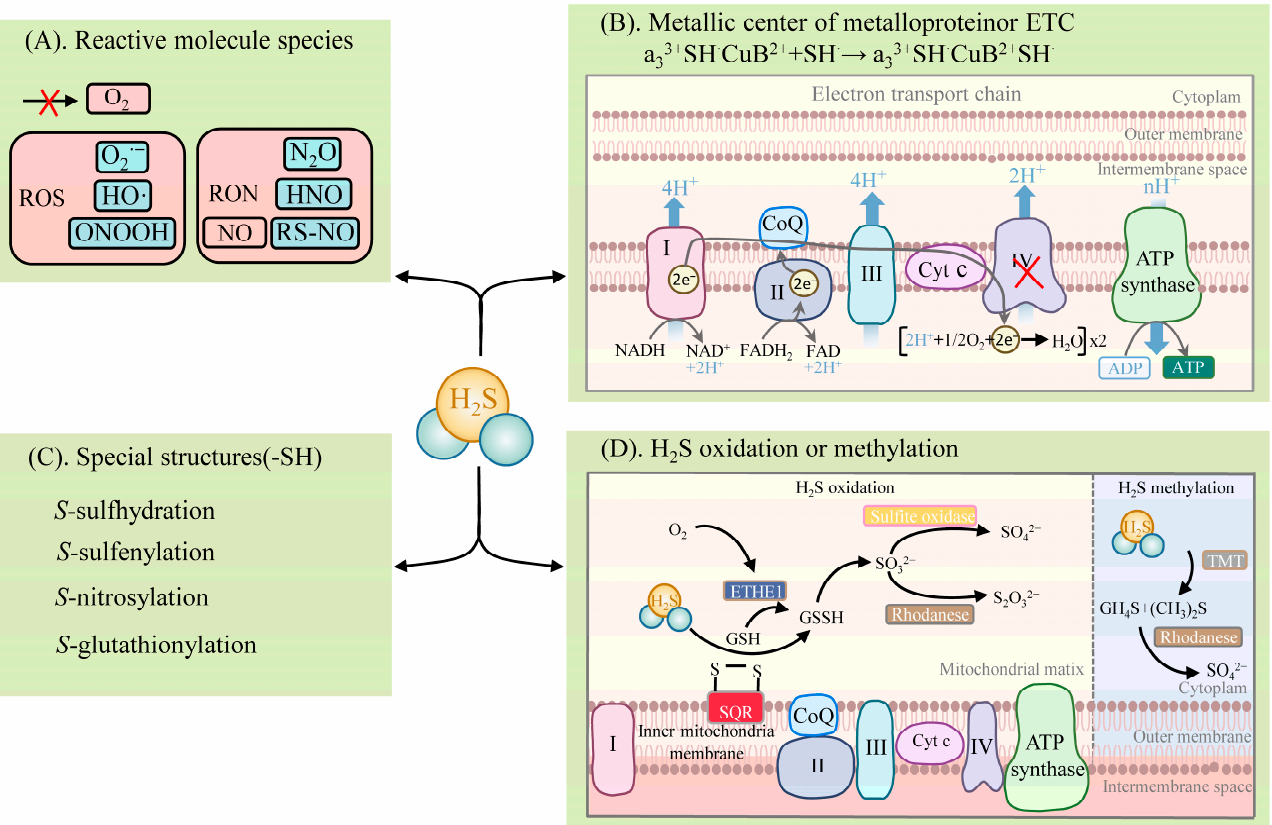
Figure 2. Metabolism of H 2 S: ( A ) reaction of H 2 S with reactive molecule species; ( B ) binding or electron transfer of H 2 S to the metal center of a metalloprotein; ( C ) reaction of H 2 S with proteins with specific structures (involved in post-translational modifications); ( D ) metabolic pathways of H 2 S oxidation and methylation. Note: I (mitochondrial complex I), II (mitochondrial complex II), III (mitochondrial complex III), IV (mitochondrial complex IV), Cyt c (Cytochrome c), CoQ (coenzyme Q/ubiquinone), CH 4 S (methanethiol), (CH 3 ) 2 S (dimethyl sulfide), ETHE1 (ethylmalonic encephalopathy 1 protein), GSH (glutathione), GSSG (glutathiol), HNO (nitroxyl), H 2 S (hydrogen sulfide), HO· (hydroxyl radicals), N 2 O (nitrous oxide), NO (nitric oxide), O 2 (oxygen), O 2• − (superoxide radical), ONOOH (peroxynitrite), RON (reactive nitrogen species), ROS (reactive oxygen species), RS-NO ( S -nitrosothiols), SO 42 − (sulfate), S 2 O 32 − (thiosulfuric acid), SO 32 − (sulfite), SQR (sulfide quinone reductase), TMT (thiol S -methyl-transferase), TST (thiosulfate sulfurtransferase). A red cross indicates an inhibitory effect on enzyme activity or the production of a substance.